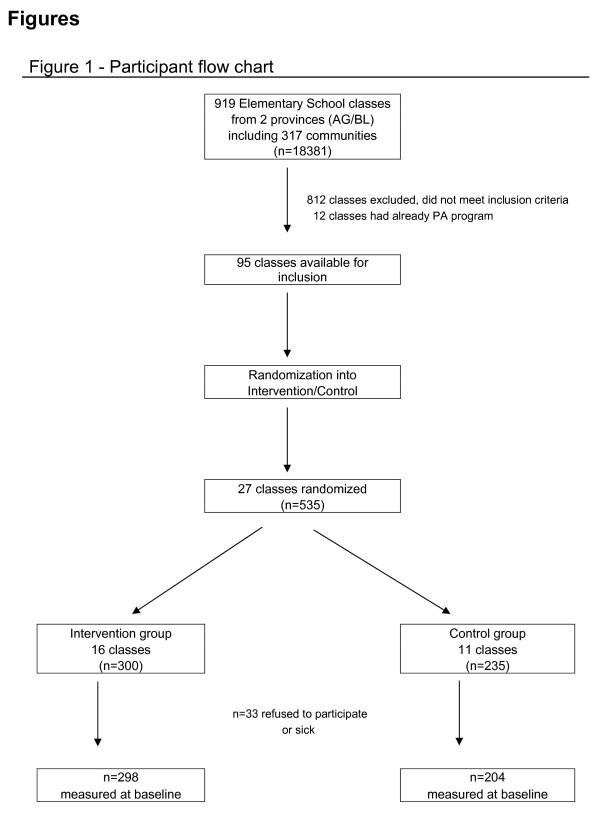
Participant flow chart.